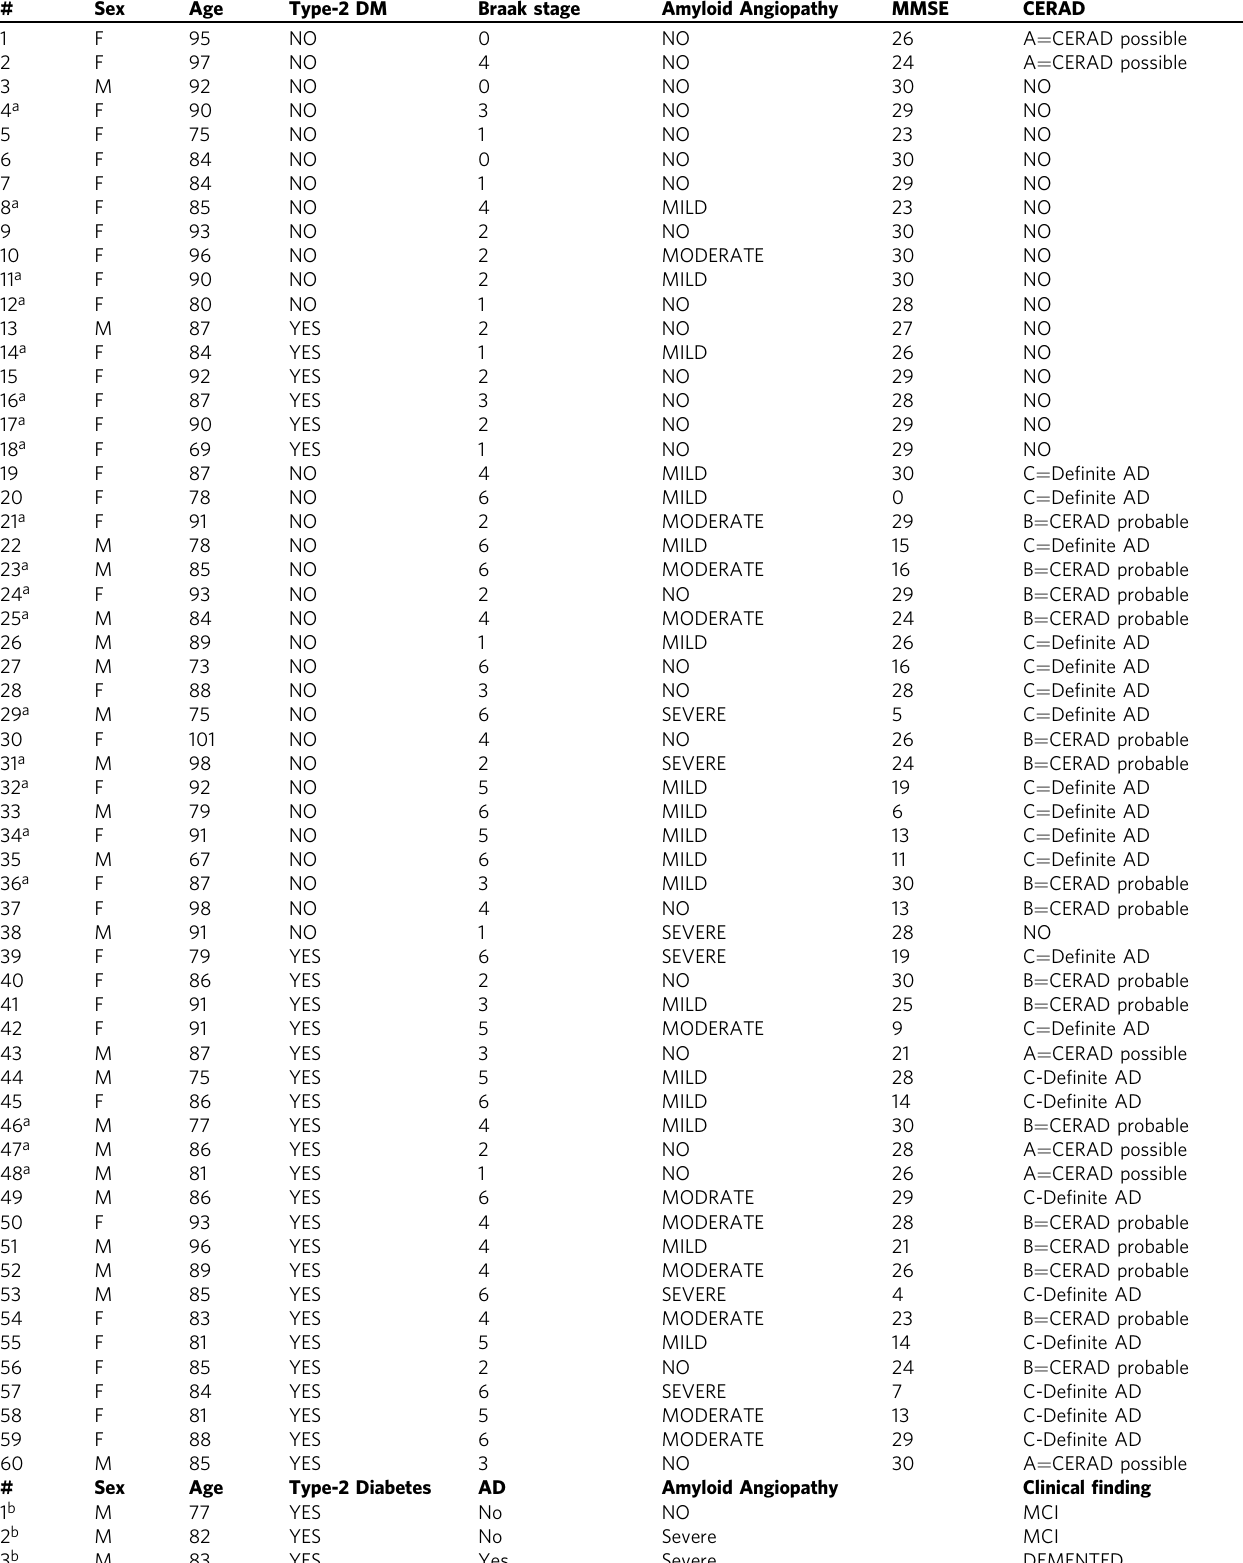
Table 2 Clinical and neuropathological information, age and sex of each individual included in the plasma amylin and brain amylin and A β analyses by ELISA, and in the IHC analysis of cerebrovascular amylin-A β